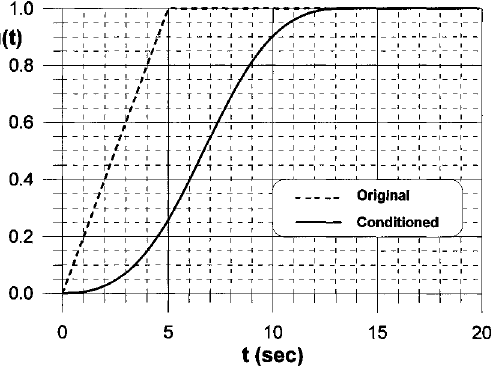
Fig. 9. Original and conditioned guidance function.